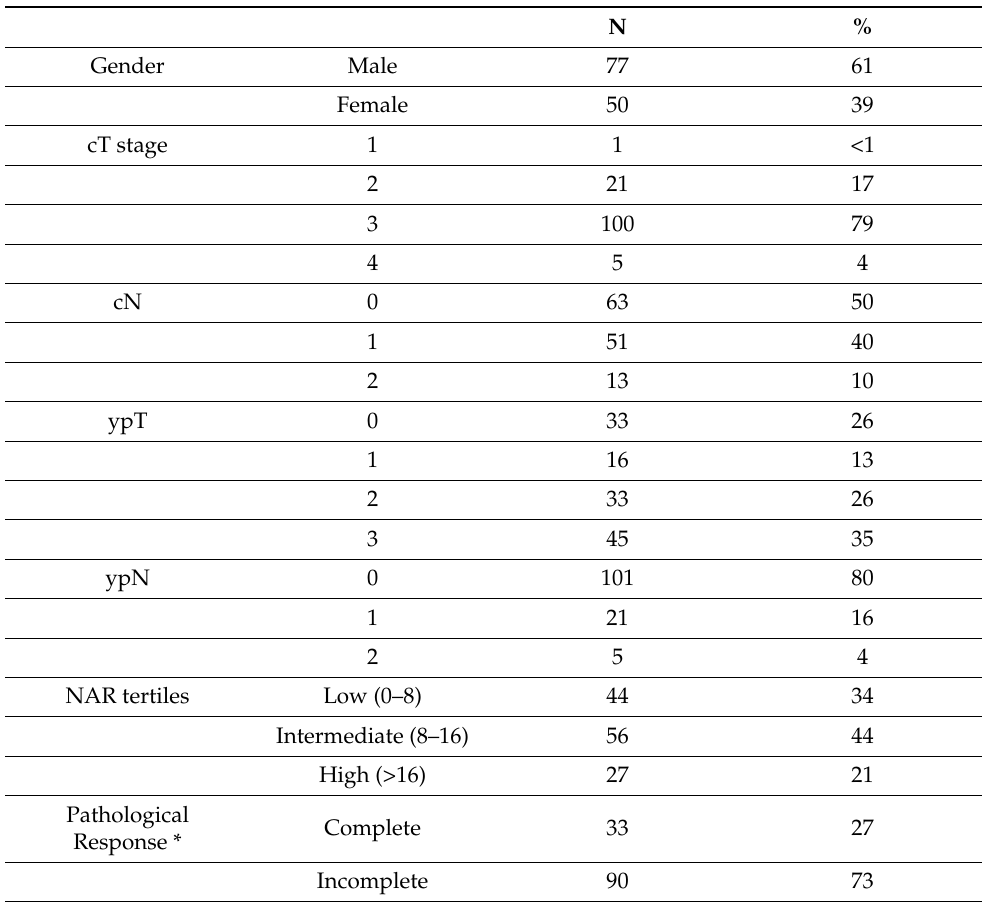
Table 1. Rectal cohort characteristics (N =